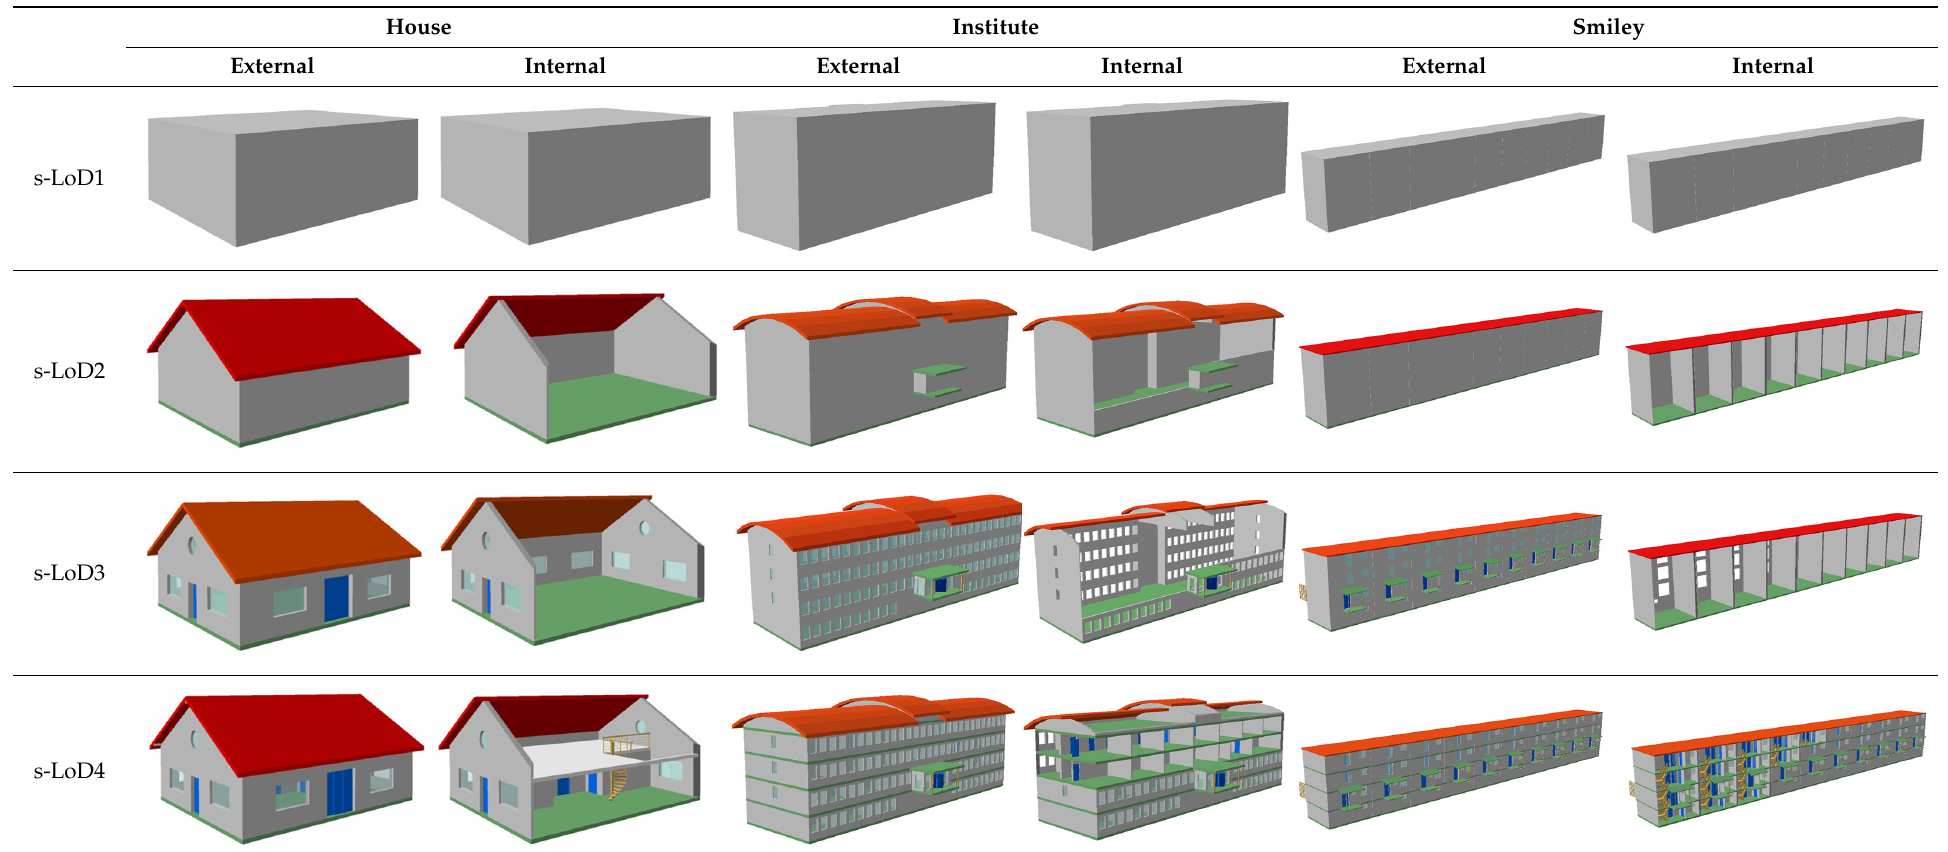
Table 6. Generated models from s-LoD1 to s-LoD4 for house, institute and Smiley building.